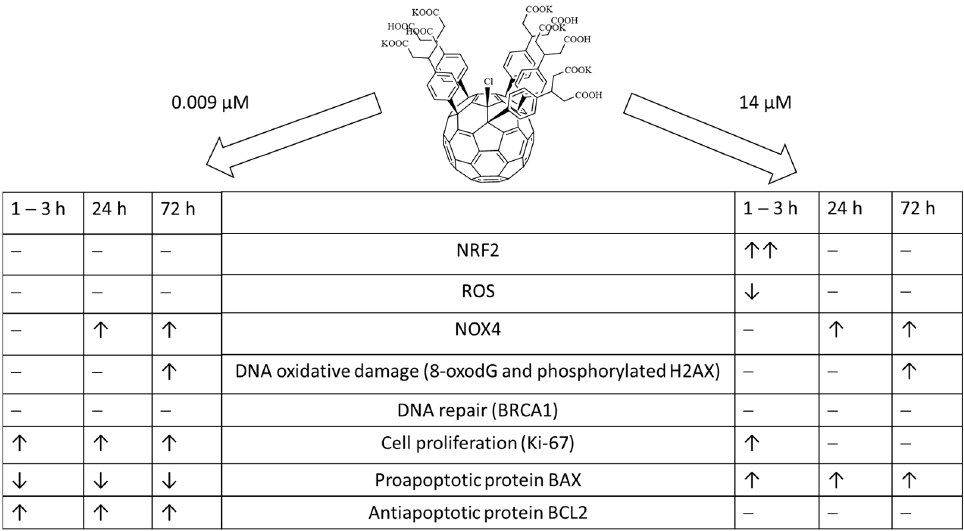
Figure 11. Effects of F1 at the minimum effective and the maximum non-toxic concentrations on